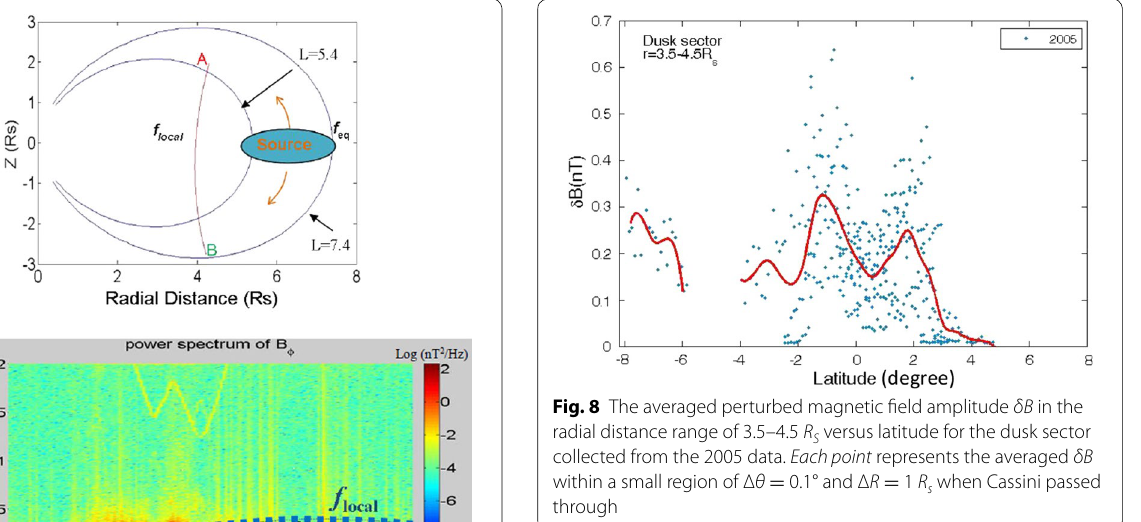
0.1° and Δ R 1 R s when Cassini passed = =